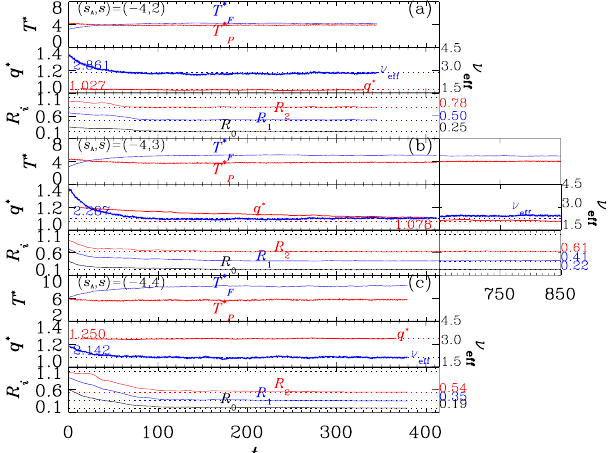
Figure 6. Time evolutions of systems with shared s A = − 4 and with ( a ) s = 2; ( b ) s = 3 and ( c ) s = 4, respectively. In each case, the top panel shows the instantaneous temperatures ⁎ T and ⁎ T for polymer and for background P F fluid, respectively; the middle panel shows the effective number of degrees of freedom ν eff per monomer and the fitted q * ; the bottom panel shows the R -parameters: R 0 , R 1 , and R 2 . The colored dashed lines in each bottom panel are plotted to show the reaching of steady values for the R 0 , R 1 and R 2 parameters, respectively. The systems were prepared as uniform configurations, with R 0 , R 1 and R 2 staying close to unity (in t < 0, not shown in the plots). The initiation of the growth is signaled by a rapid falling in R 0 , corresponding to the entry into stage II on the triggering of paralleled segments in stage I (Fig. 1(d)). It is followed sequentially by the fallings of R 1 and R 2 , which mark the reaching of stage III and stage IV, respectively. The latter (stage IV) is featured by the formation of bundled structures (Fig. 7) which may start immediately after the initiation of the previous one (stage III) 48, 49 ; the system in plot (c) has an apparent well separated initiations for the two stages. Each data point for q * is an average on 100 data points over a shift window of Δ t = 25 τ , which is 100 times of that used for Figs 2(b) and 5, in computing the values of the parameter. q * and ν eff are plotted in spacing of 0.25 τ . The curves of both quantities are guided by horizontal dashed lines to show their convergence towards constants, except that of q * in plot (b) for the system with s = 3. In the latter system, q * decreases with time t , in contrast to ν eff which barely changes. Data in an extended simulation of the system are also plotted on the right of in plot (b), which shows continuing decreasing trend in q * . The factor ν eff , on the other hand, encounters a major change separately from that in q *